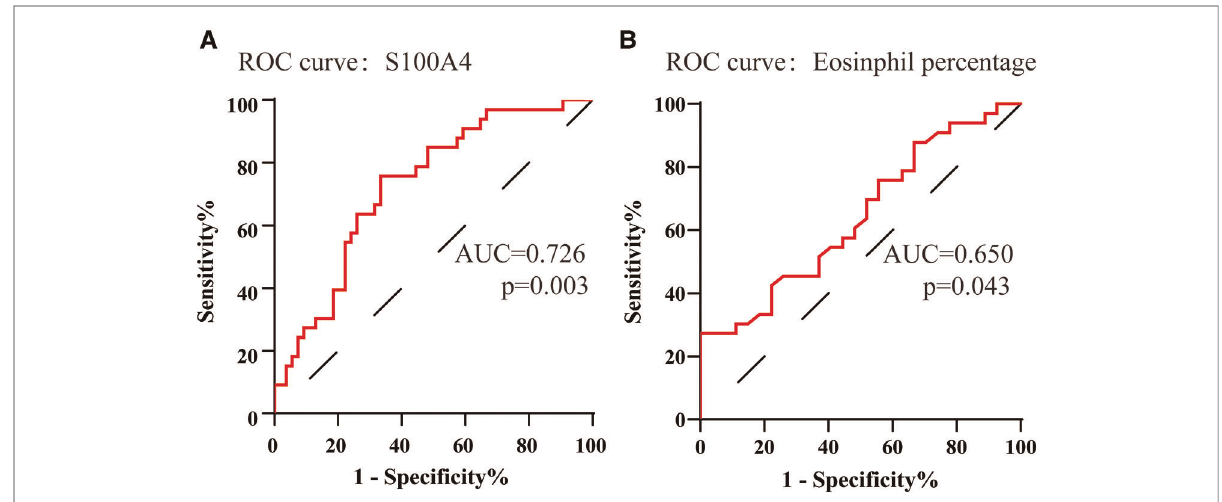
FIGURE 3 The ROC curves of potentially predictive biomarkers for discriminating EOS CRSwNP. ( A ) serum S100A4; ( B ) peripheral eosinophil percentage. Abbreviations: ROC, receiver operating characteristic; EOS CRSwNP, eosinophilic chronic rhinosinusitis with nasal polyps.